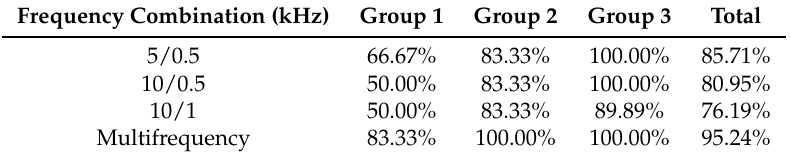
Table 2. Performances of the impedance ratio method and neural network-based multifrequency